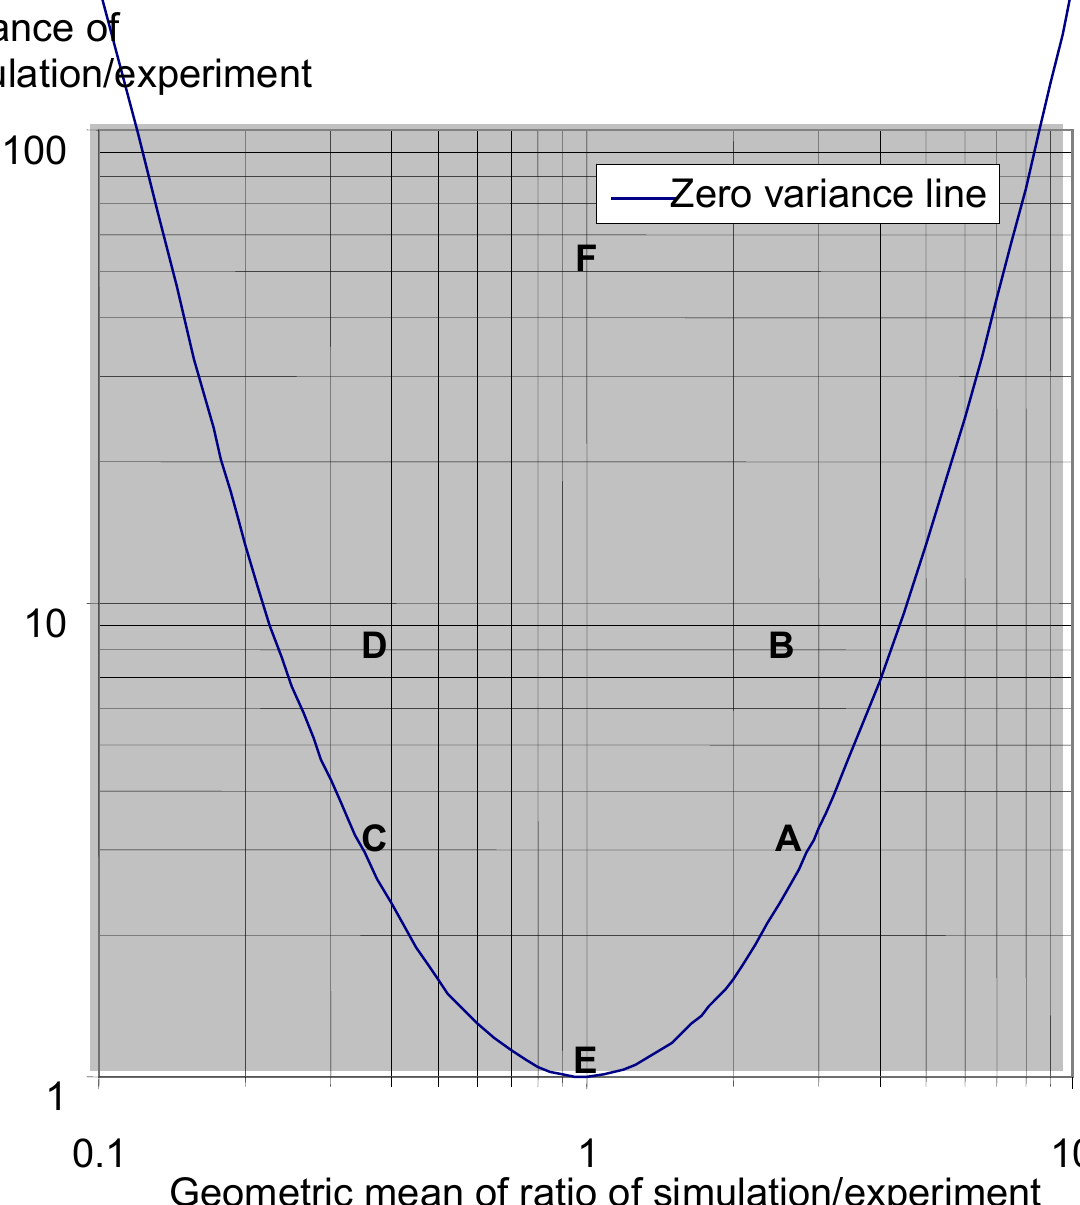
Figure 4. An example MV diagram (taken from [2]). The curve is the zero-variance line. Point A is close to the zero-variance line: it indicates the model consistently overpredicts and has a very low probability of underprediction. Point B is above A and has a high variance: it indicates that the model, though it has a tendency to overpredict, has a wide range of prediction; some are underpredicted—model B is less predictable than Model A. Points C and D are similar to Points A and B, but underpredict. Point E is close to the bottom of the lowest parabola; this indicates consistently accurate prediction of experimental data. Point F is unbiased; it has a very high variance; a model with this property is of little use in practice as it behaves like a random number generator.